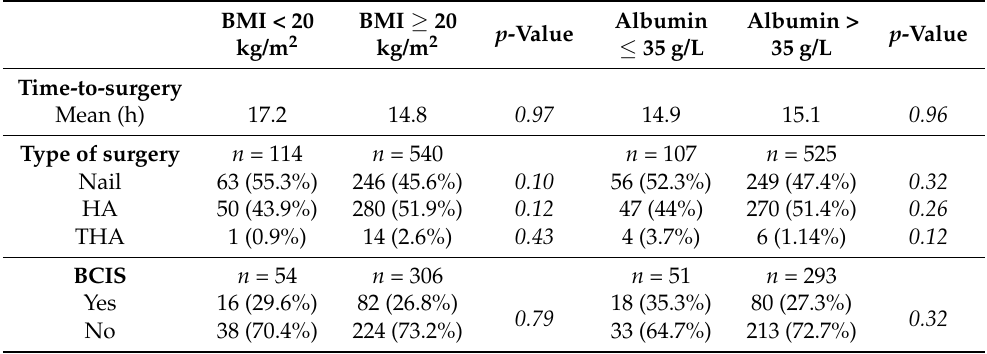
Table 3. Comparison of the treatment data between the patients with a BMI greater or less than 20 kg/m 2 and albumin greater or less than 35 g/L. The number of patients with data is given separately for each parameter. ASA grade, American Society of Anesthesiologists; ISAR, Identification of Seniors At Risk; IQR, interquartile range; BMI, body mass index; h, hour; HA, hemiarthroplasty; THA, total hip arthroplasty; BCIS, bone cement implantation syndrome; g, gram; kg, kilogram; m, meter; L, liter; dL, deciliter; ml, milliliter; CPR, cardiopulmonary resuscitation; RCC, red cell concentrate; IBP, invasive blood pressure measurement; CVC, central venous catheter; ICU, intensive care unit. * Significant